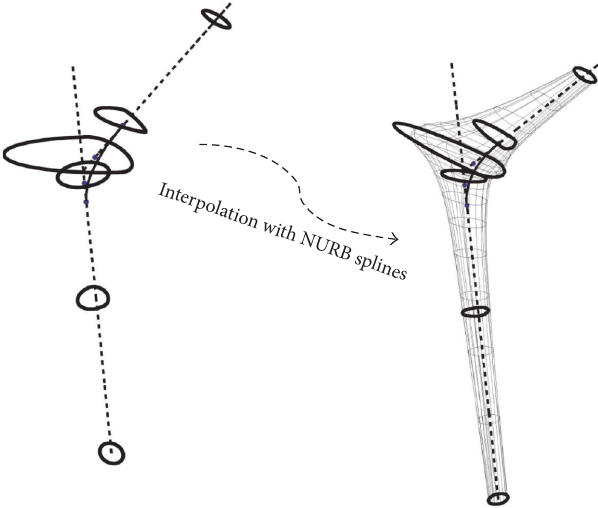
Figure 3: A series of NURB splines interpolated between the skeleton cross sections (left) to produce the hip model shown on the